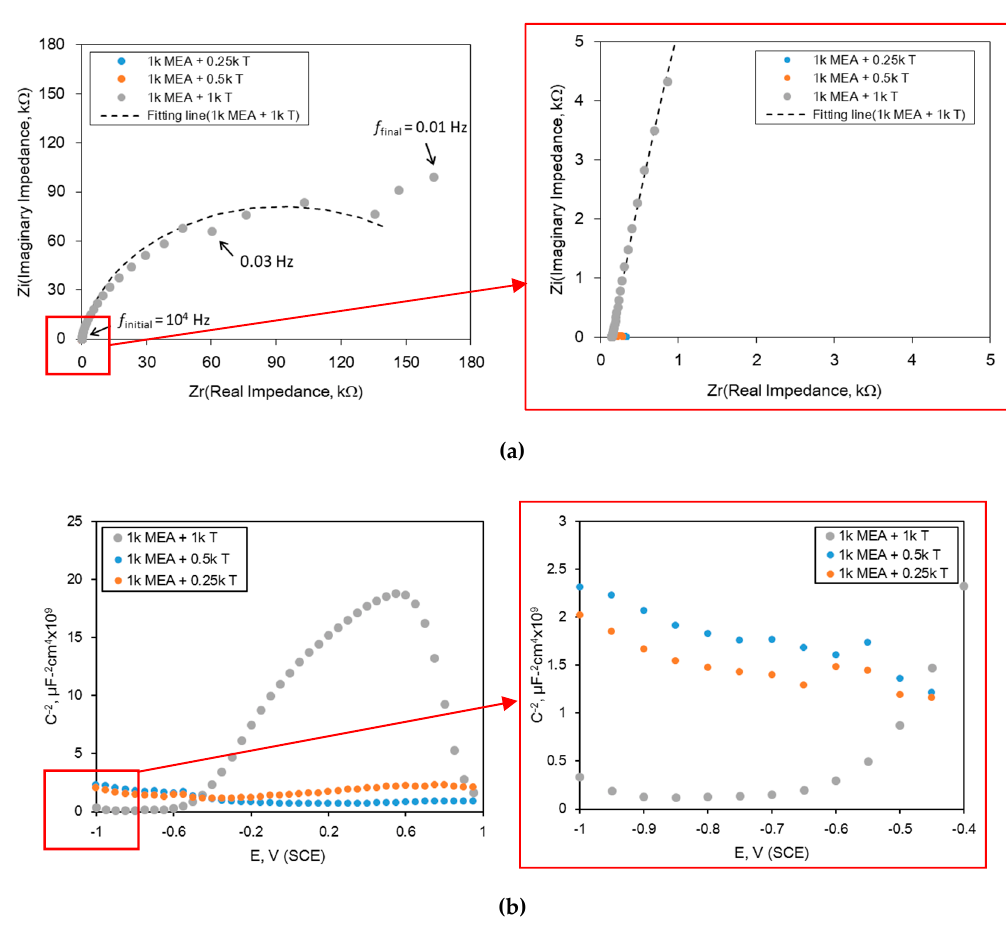
Figure 7. Effect of co-addition of corrosion inhibitors on the ( a ) Nyquist plot and ( b ) Mott-Schottky plot of the passive film formed at 0 V(SCE) in deaerated [tap water + 1 k ppm monoethanolamine (MEA) + x ppm tungstate (T)] at 30 °C.